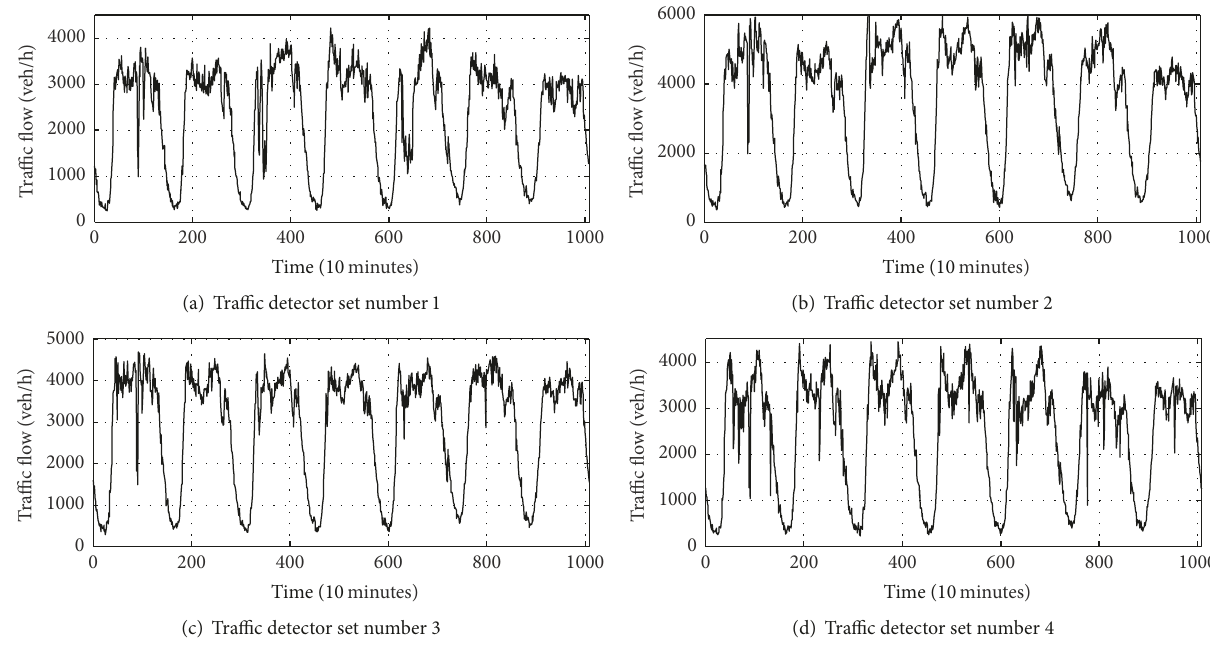
Figure 5: Traffic flow count data of test week for the four detector